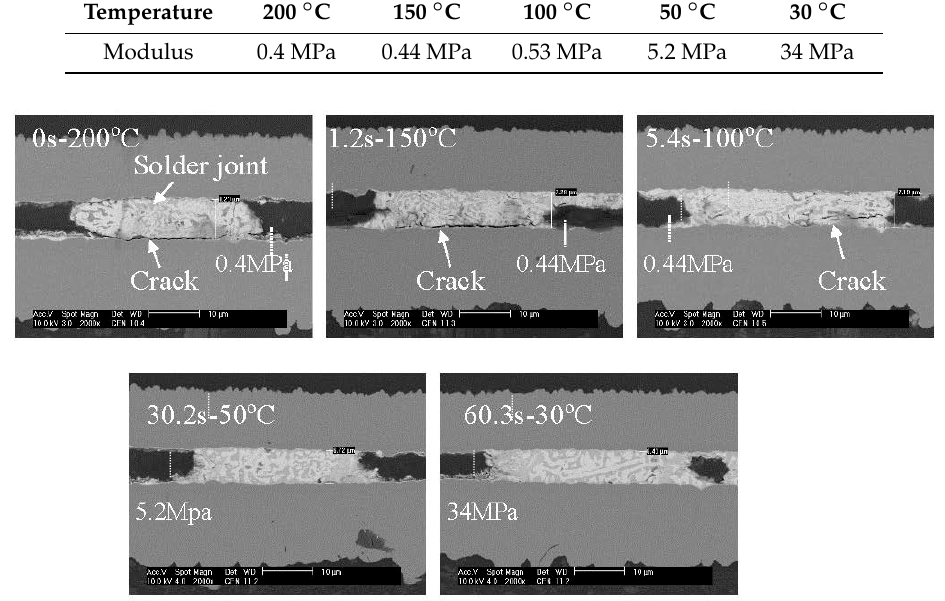
Figure 22. Effects of delaying ultrasonic horn lift-up times (0, 1.2, 5.4, 30.2, and 60.3 s) on the SnBi58 solder ACFs joint morphologies.